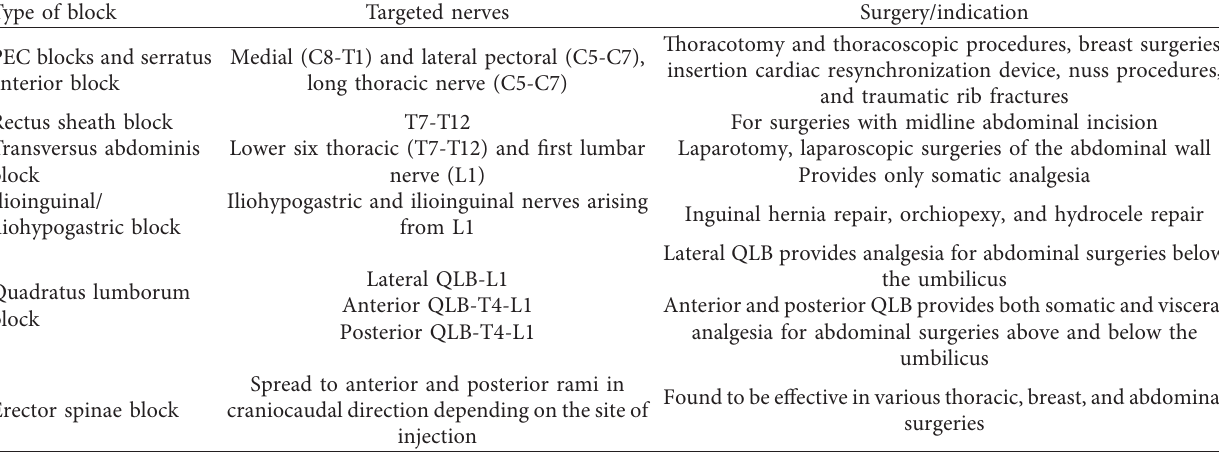
Table 1: The table shows various surgeries in which interfascial plane blocks are commonly used and the nerves targeted for the cor- responding blocks.